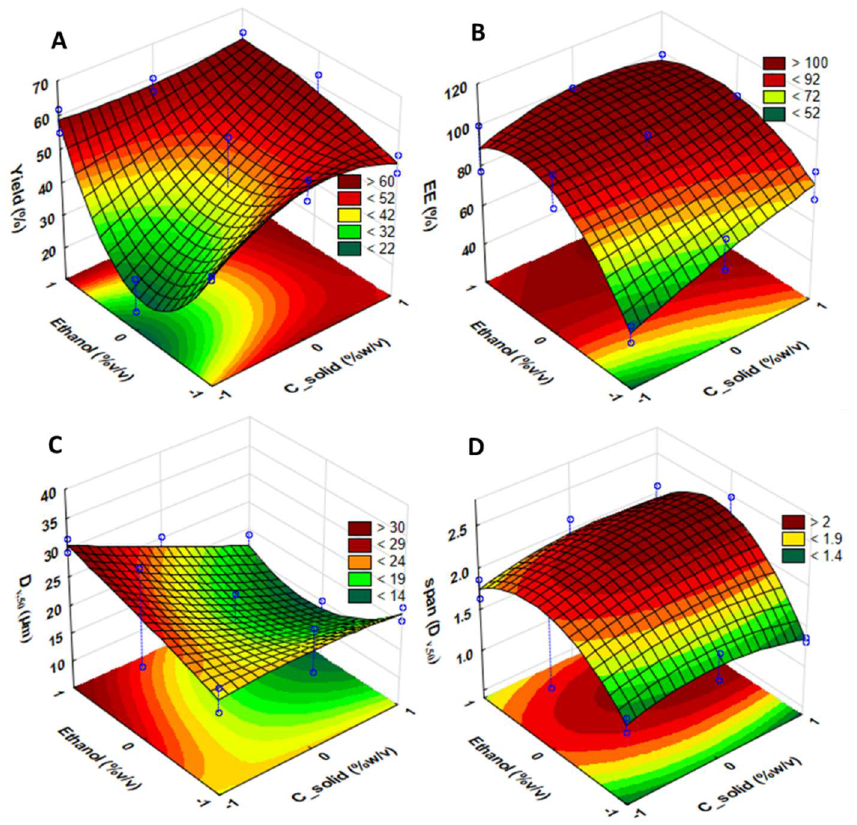
Figure 3. Fitted ANOVA surface plots for each GA–DPF response: ( A ) process yield; ( B ) encapsulation efficiency ( EE ); ( C ) particle size (D v,50 ); and ( D ) span.